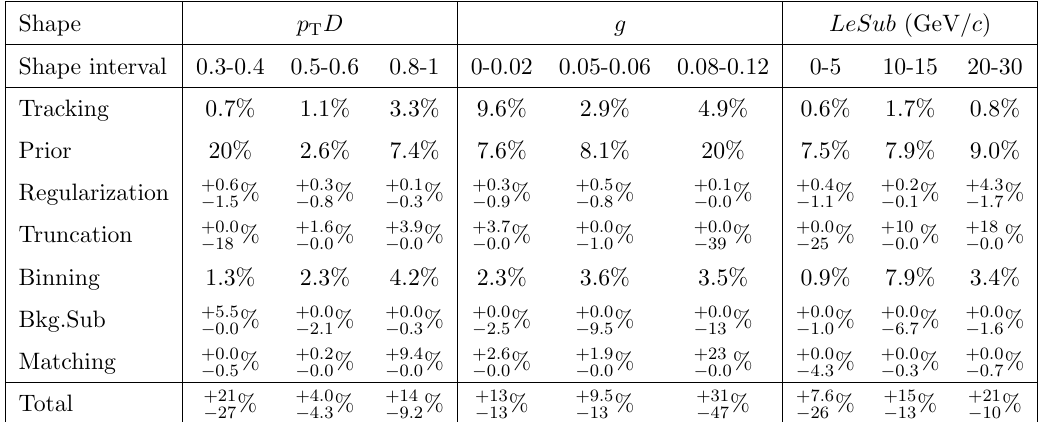
Table 2 . Relative systematic uncertainties on the measured jet shapes in Pb-Pb collisions for three selected jet shape intervals in the jet p ch range 40{60 GeV/ c T ; jet